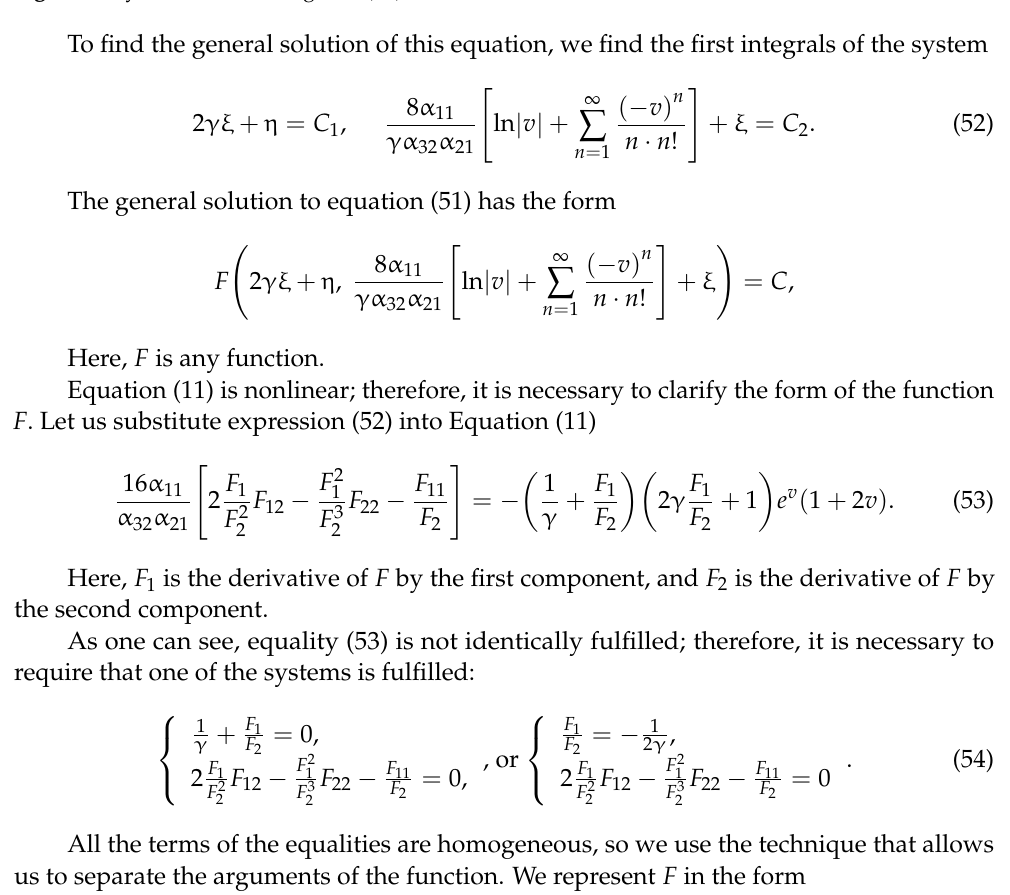
Figure 3. Cylindrical surface guide (50), where n = 1, 2, . . . ,